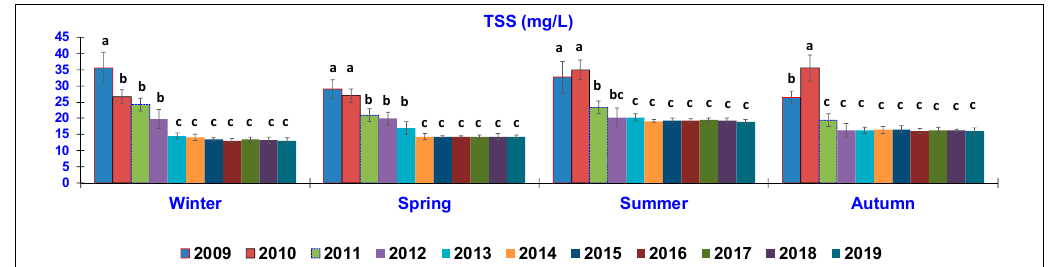
Figure 2. Trend of outlet water Total Suspended Solids (TSS) (mean ± standard deviation) seasonally determined during the 10 year-study. Different letters (a, b, c) per season show significant differences ( p < 0.05) among the 10 years of sampling.